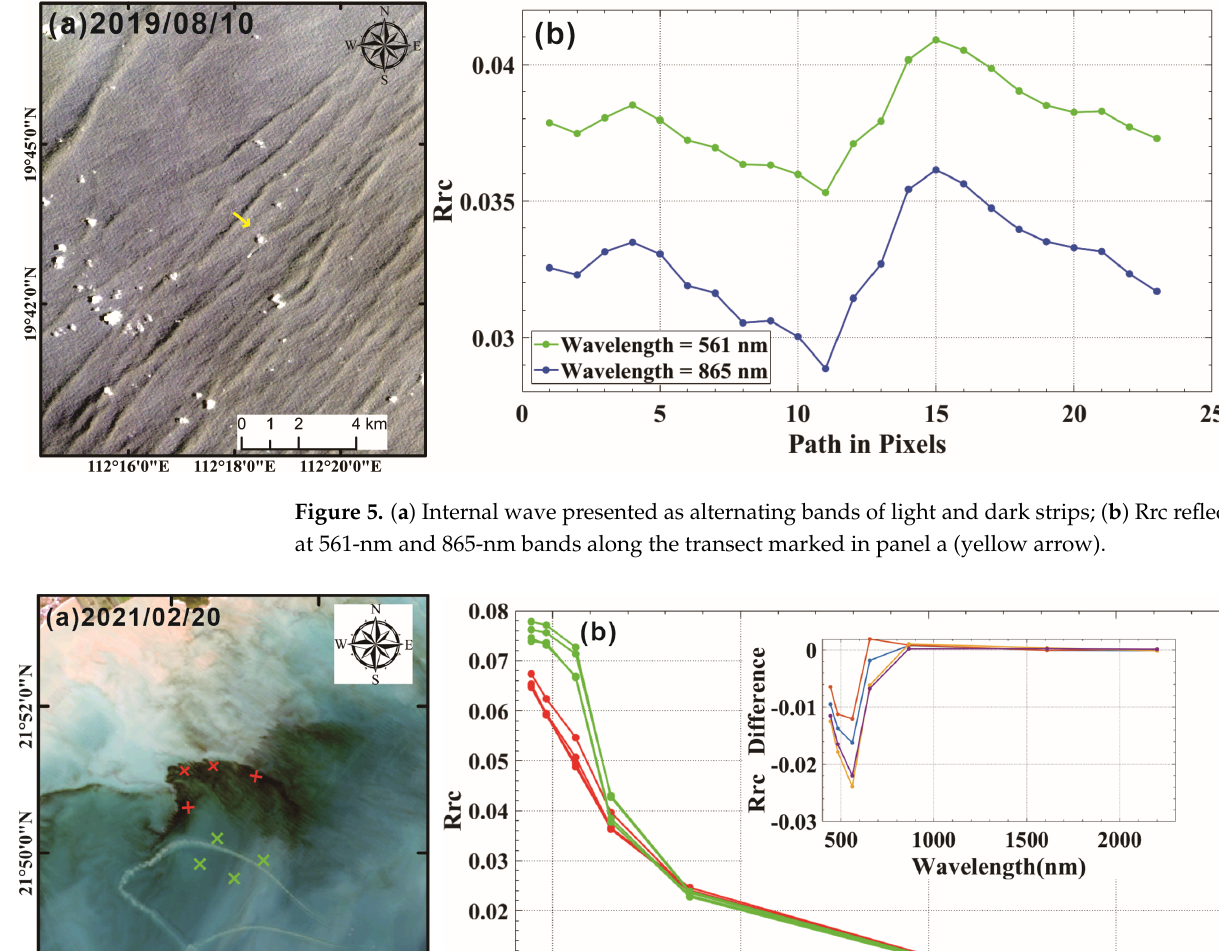
Figure 5. ( a ) Internal wave presented as alternating bands of light and dark strips; ( b ) Rrc reflec ‐ tance at 561 ‐ nm and 865 ‐ nm bands along the transect marked in panel a (yellow arrow). Floating algae of various forms could resample oil slicks in optical imagery [35].